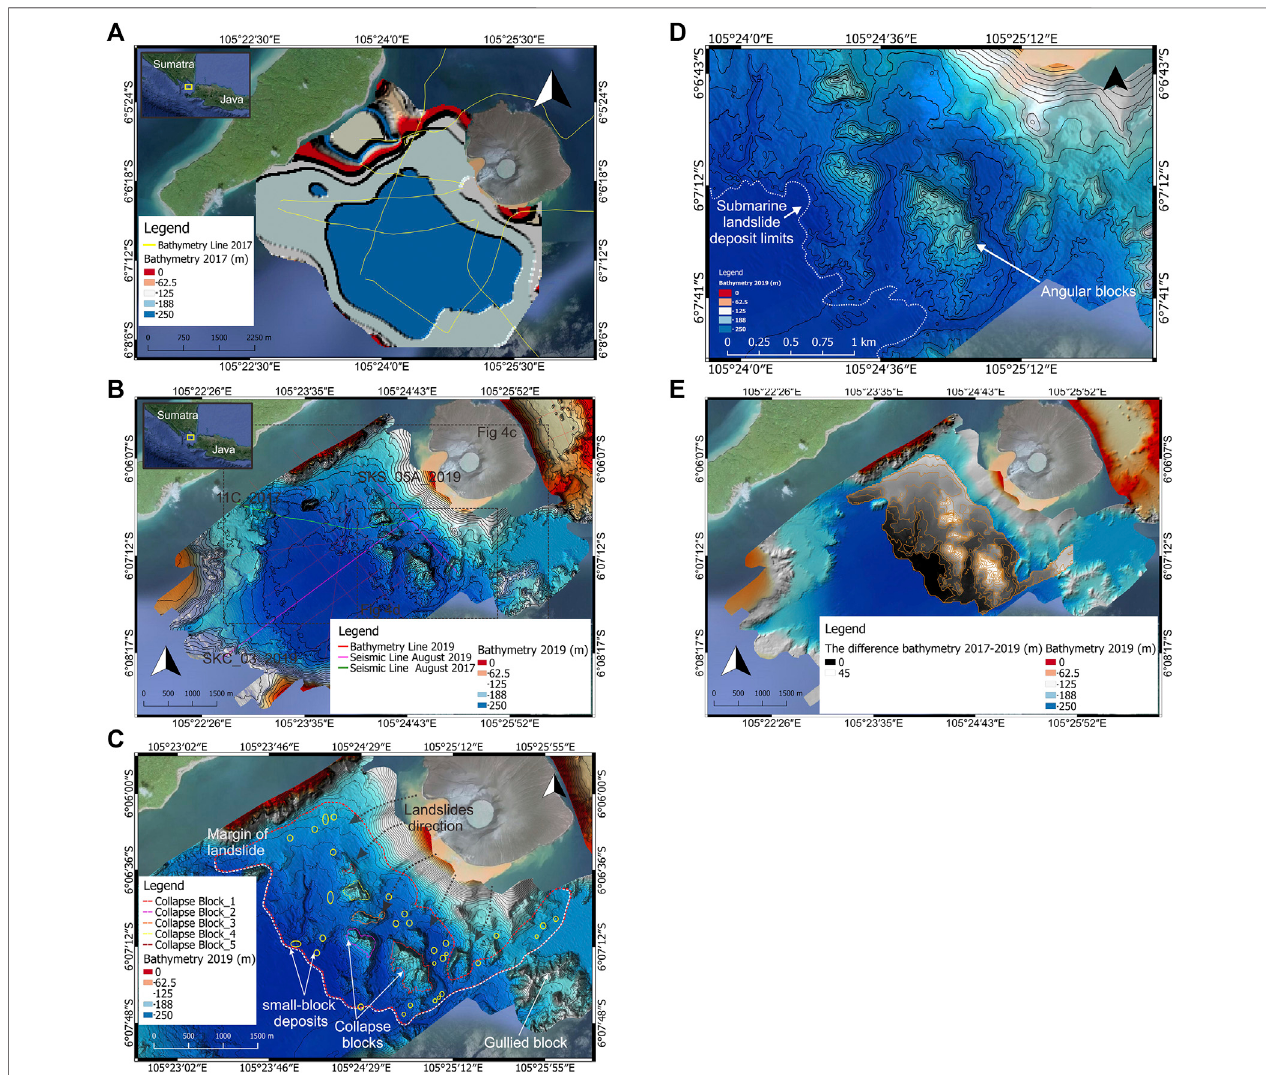
FIGURE 4 | Bathymetry map shows the collapse block result from 22nd December 2018 AK eruption. (A) Single-beam bathymetry maps acquired in 2017. (B) Multi-beambathymetrymapsacquiredin2019. (C) Bathymetrymaps2019withinterpretationofsea fl oormorphologypost-eventofthe fl ankcollapse(Thewhite-striped lineinterpretedmarginofthecollapse,thered-stripedlineistheestimationofthecoverageareaofthelandslide,theyellow-roundedconsideredassmall-blocksdeposit). (D) Bathymetry maps 2019 with blow up the limit of the landslide. (E) The volume area resulted from the subtraction between bathymetry acquired in 2019 and acquired in 2017.